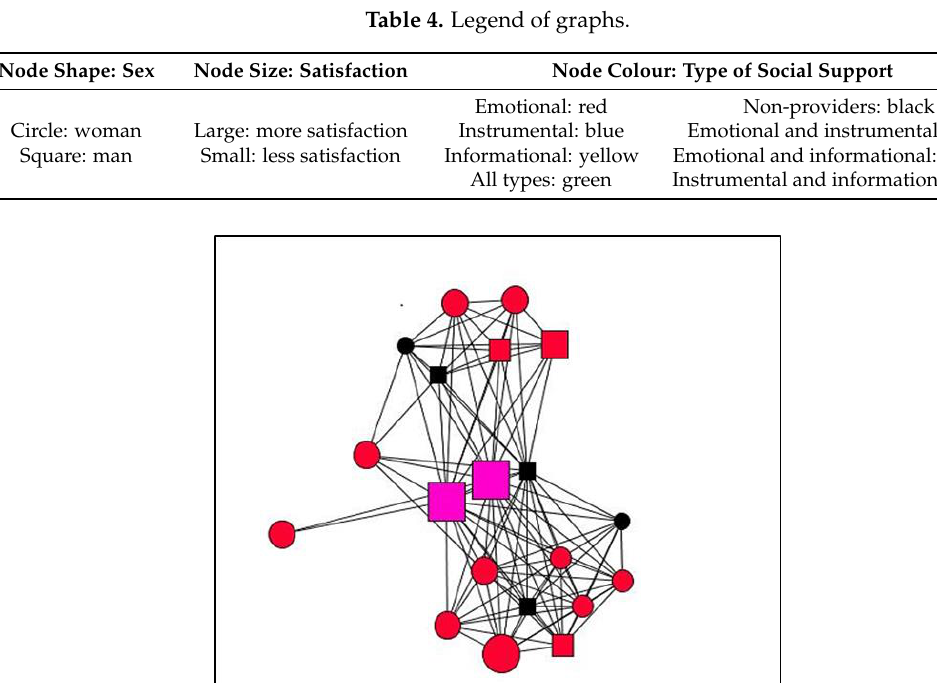
Figure 2. Graph Case 24. Woman, 53 years old, 3 years with chronic pain.